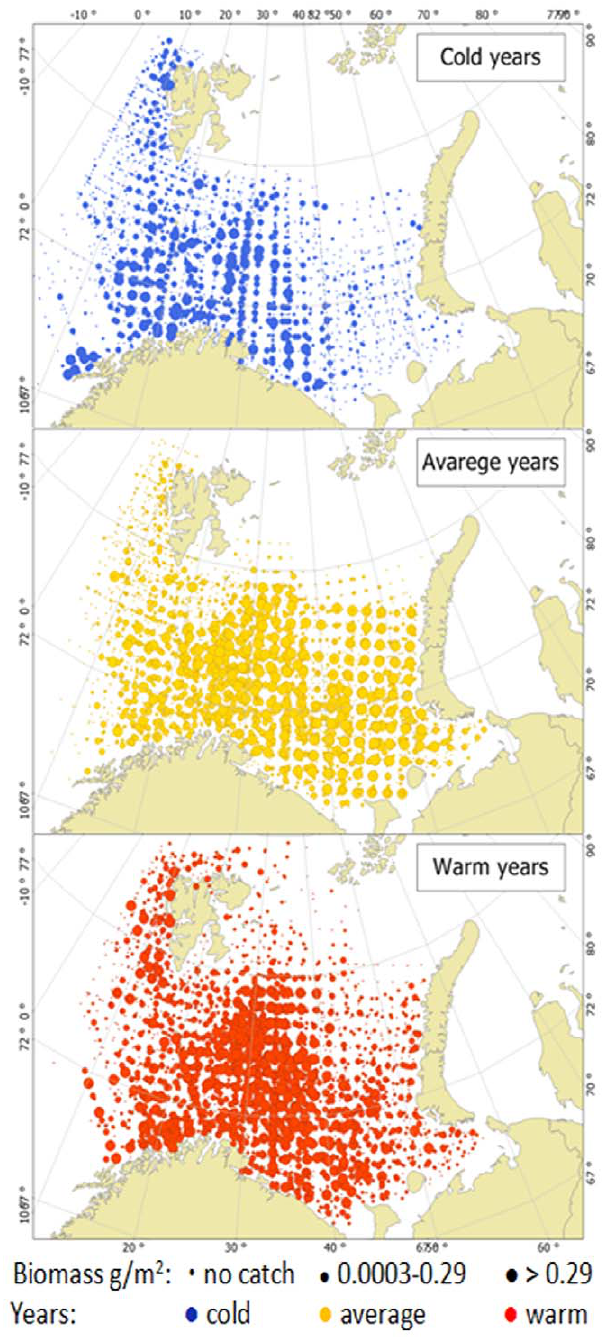
Figure 4. Spatial distribution of jellyfish biomass (wet weight g/m 2 ) during years with different temperature regimes in the Barents Sea (see Figure 3). Cold years are shown in blue (up), average in yellow (middle) and warm years in red (bottom). Circle size indicates biomass; stations with no jellyfish are shown with the smallest circle size, 0.0003–0.29 g/m 2 with the medium circle, and with more than 0.29 g/m 2 jellyfish shown with the largest circle size.